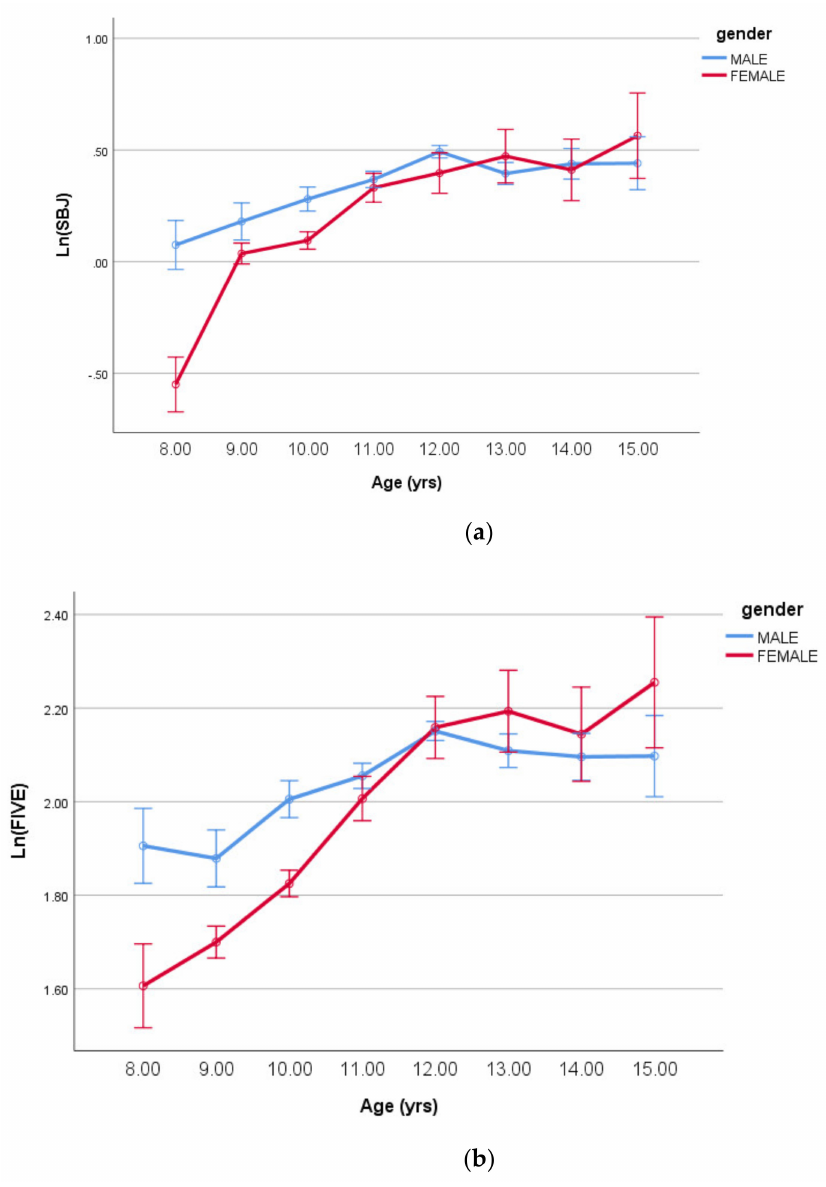
Figure 2. ( a ) Log-transformed standing long jump (means ± SE) by age having controlled for body size/shape and maturity offset (covariates in Table 3). ( b ) Log-transformed five jump test (means ± SE) by age having controlled for body size/shape and maturity offset (covariates in Table 3). The body mass and height exponents associated with the SLJ (Table 3) and 5JT (Table 3) can be rearranged and expressed as a height-to-mass ratio within a curvilinear power function as follows: Height-to-mass ratio (LnSLJ) = mass − 0.25 · height 1.45 = (height · mass − 0.17 ) 1.45 , Height-to-mass ratio (LnFIVE) = mass − 0.16 · height 1.26 = (height · mass − 0.12 ) 1.26 , since, for example, in the LnSLJ model mass − 0.25 = (mass − 0.17 ) 1.45 . Note that both these height-to-body mass ratios could be described as “extreme” RPI, where the mass exponents are considerably less (mass − 0.17 and mass − 0.12 , respectively) than the anticipated mass exponent (mass − 0.333 ) for the